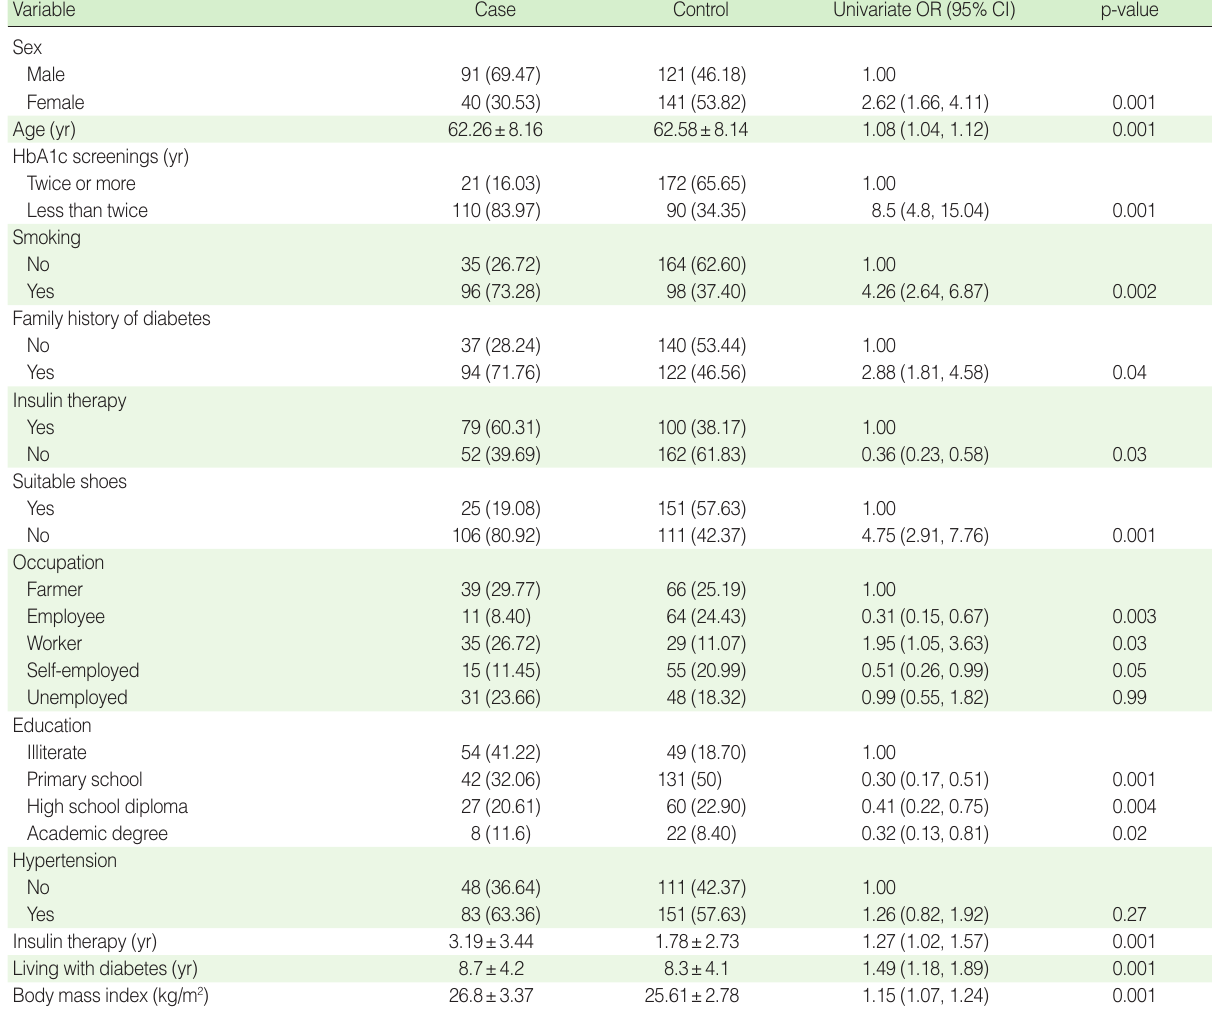
Table 1. Characteristics of the participants in the case and control groups